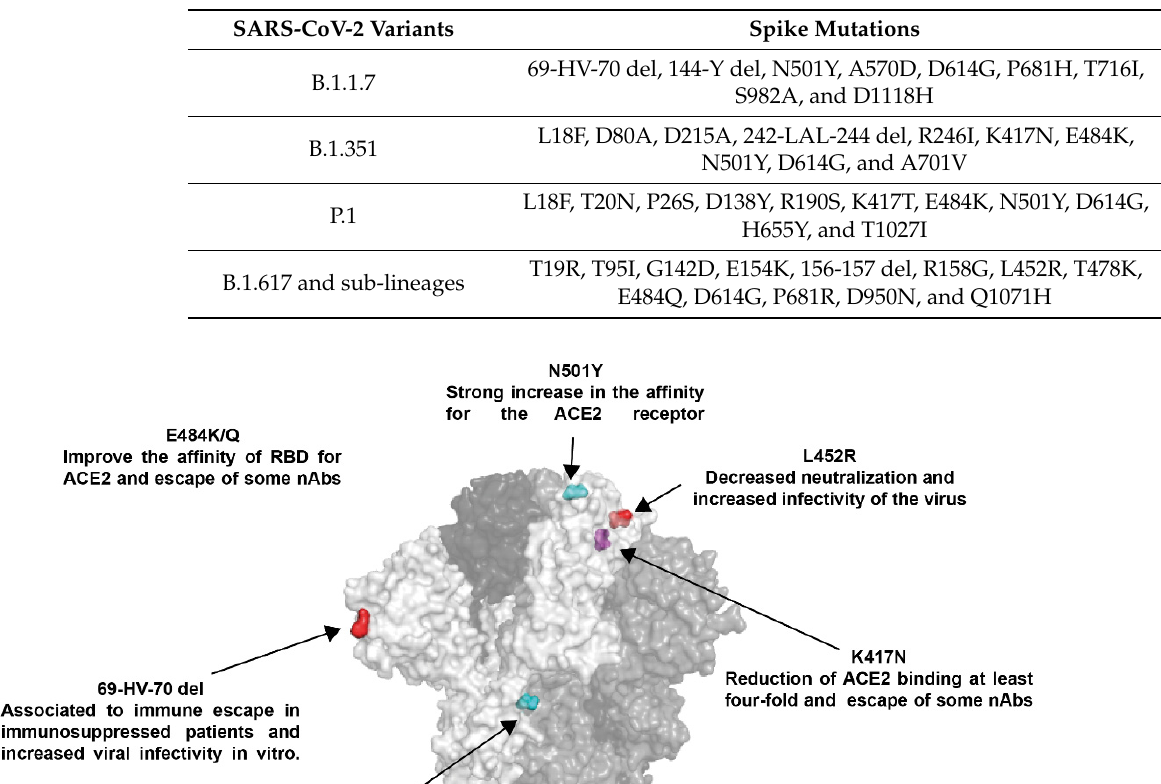
Table 1. Mutations in S glycoprotein of SARS-CoV-2 variants.